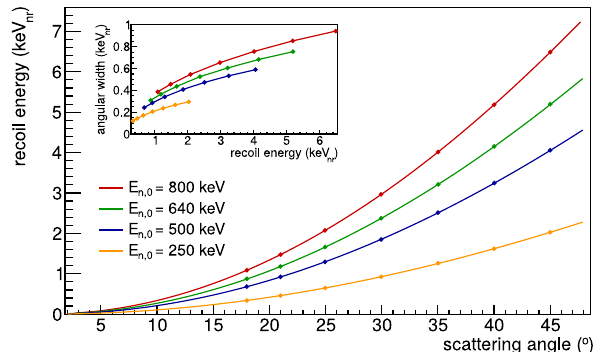
Fig. 8 Nuclearrecoilenergyobtainedingermaniumforincomingneu- trons with energies 250–800keV as a function of their scattering angle, according to Eq. (3). The expected angular spreads for the chosen setup are represented in the inset. The dots indicate the angles chosen for the measurement